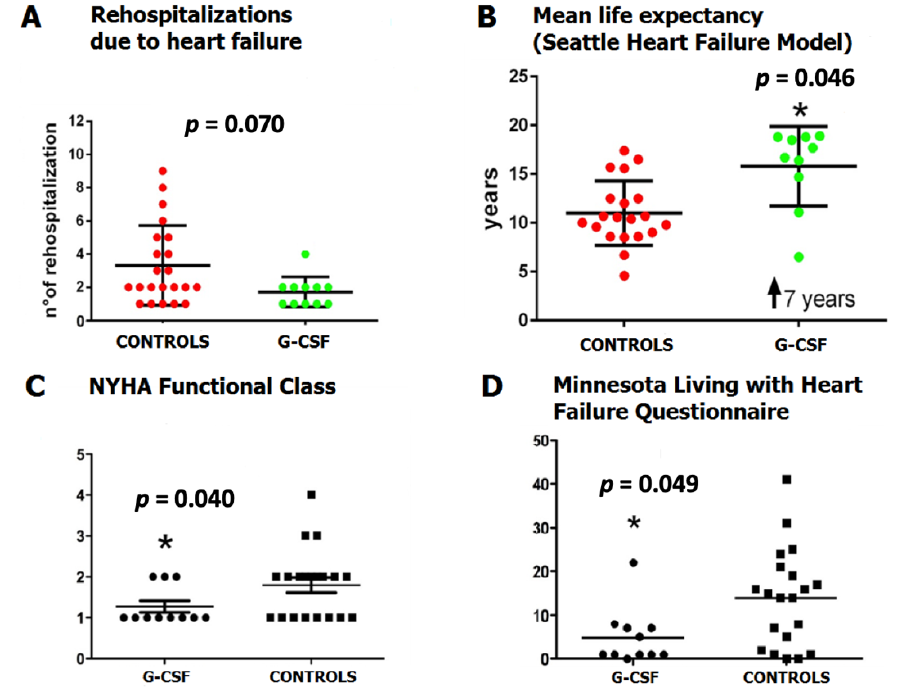
Figure 4. ( A ) Heart failure-related rehospitalization events, ( B ) Mean life expectancy calculated by Seattle Heart Failure Model (SHFM) between controls and G-CSF treatment group, ( C ) New York Heart Association (NYHA) functional classification of heart failure severity in G-CSF group compared to control, ( D ) MLHFQ mean score between G-CSF group and control group.